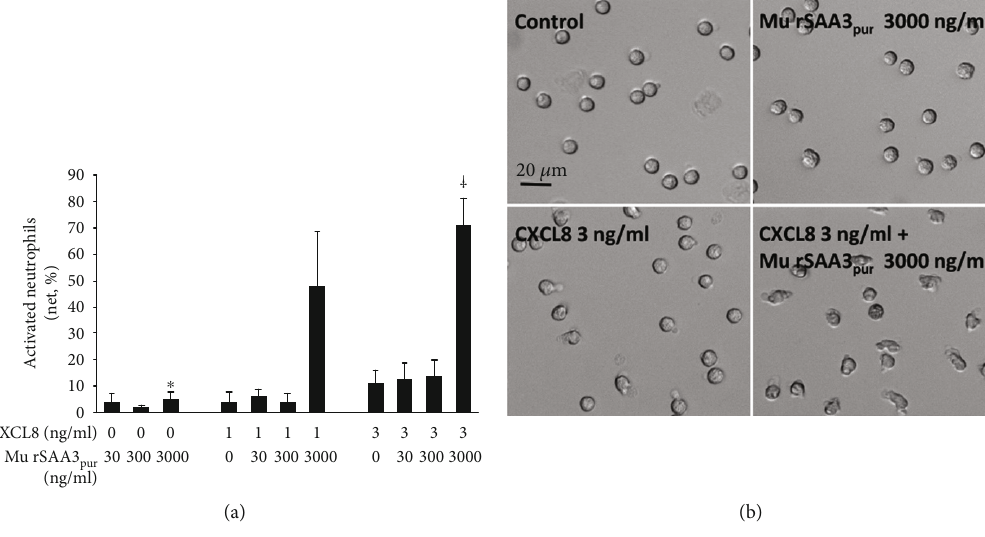
Figure 9: Mu rSAA3 synergizes with CXCL8 in neutrophil activation. Activation of human neutrophils was assessed via shape change pur assays. Neutrophils were stimulated for a period of 3min with di ff erent concentrations of CXCL8 (1 or 3ng/ml), mu rSAA3 (30- pur 3000ng/ml) or were left untreated. After fi xation of cells, non-activated resting (round) and activated (blebbed and elongated) neutrophils were counted microscopically by 2 individuals independently. (a) Data represent the mean netpercentage of activated neutrophils ± SEM derived from 4 independent experiments. Statistically signi fi cant activation of neutrophils (compared to controls) and statistically signi fi cant synergy (compared to the sum of the values when both agonists are tested separately), determined by the Mann-Whitney U test, are indicated by asterisks ( ∗ p < 0 : 05 ) and daggers ( † p < 0 : 05 ), respectively. (b) Phase contrast image (20x magni fi cation; scale bar: 20 μ m) of one representative experiment illustrating the morphological change of neutrophils following stimulation with bu ff er (control), CXCL8 (3 ng/ml), mu rSAA3 (3000ng/ml) or a combination of CXCL8 and mu rSAA3 are pur pur